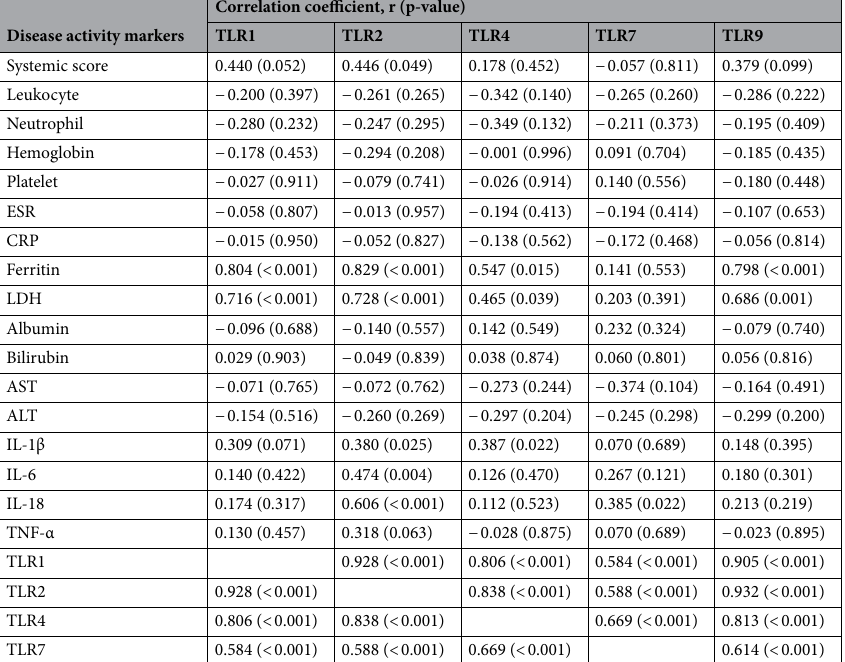
Table 2. Correlation between each Toll-like receptor (TLR) level and levels of disease activity markers in adult onset Still’s disease. ESR, erythrocyte sedimentation rate; CRP, C-reactive protein; LDH, lactate dehydrogenase; AST, aspartate transaminase; ALT, alanine transaminase; IL, interleukin; TNF, tumor necrosis factor. Spearman’s correlation coefficients were calculated. The systemic scoring system of Pouchot et al. 40 assigns a score from 0 to 12 with 1 point for each of the following manifestations: fever, typical rash, pleuritis, pneumonia, pericarditis, hepatomegaly or abnormal liver function test data, splenomegaly, lymphadenopathy, leukocytosis ≥ 15,000/mm 2 , sore throat, myalgia, and abdominal pain. These data were assessed using a Spearman’s correlation